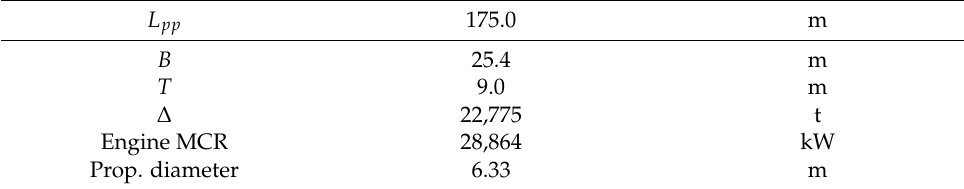
Figure 3. Path of the considered route.